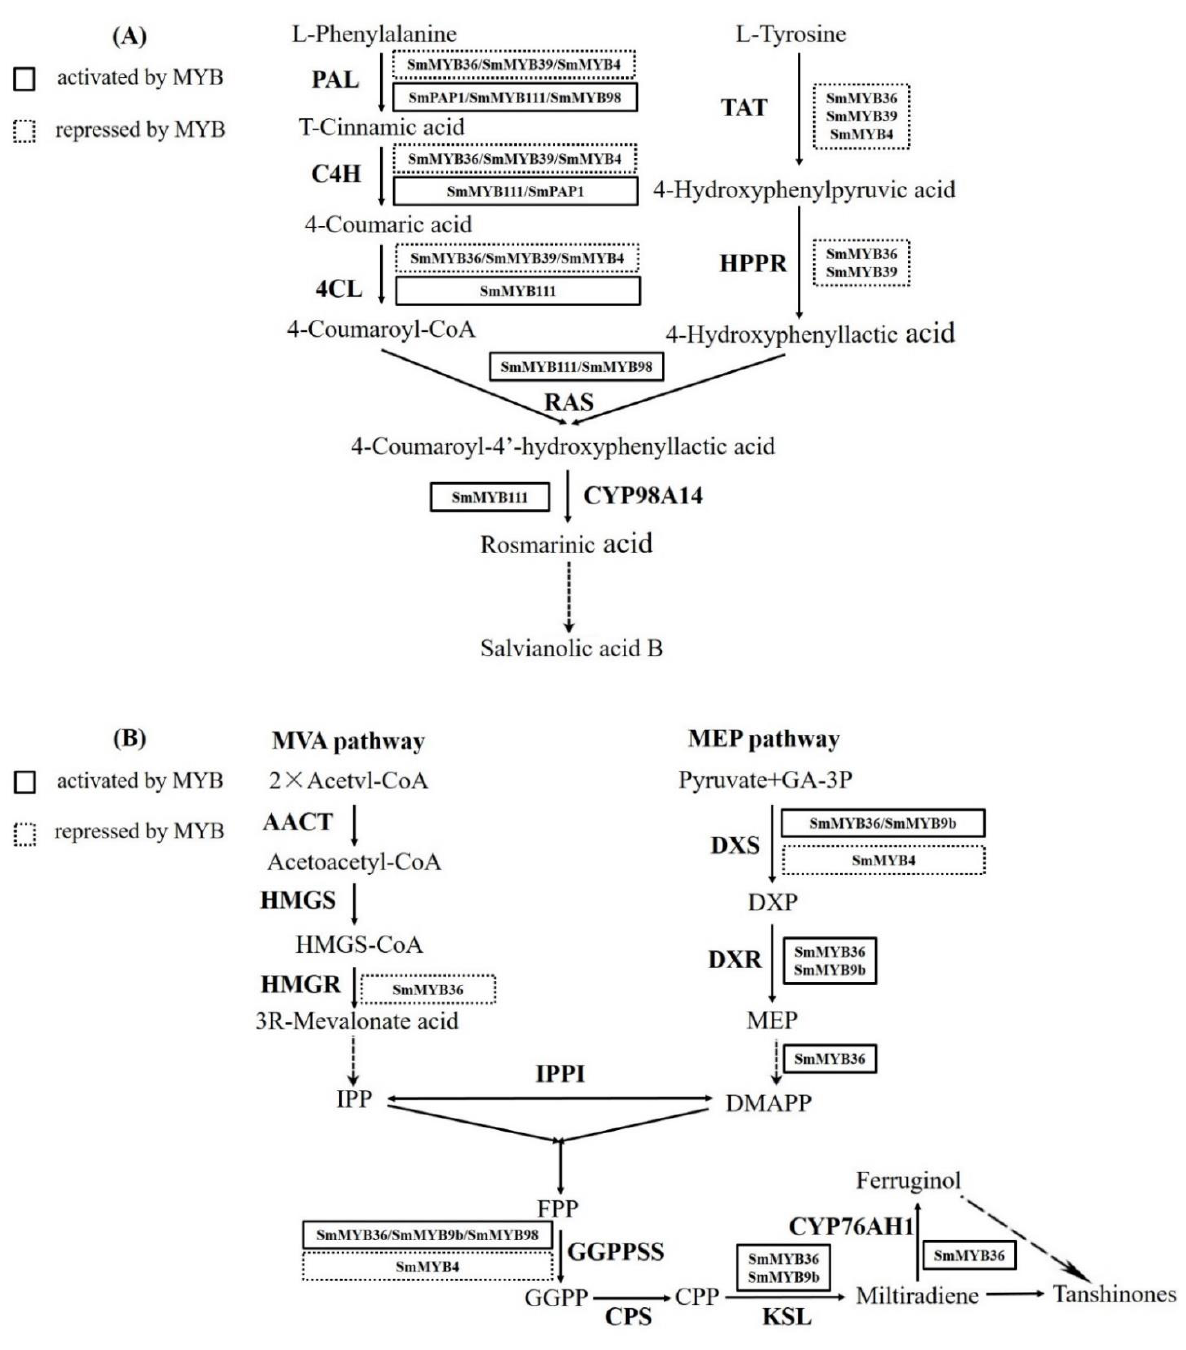
Figure 7. Multiple R2R3-MYBs regulating the salvianolic acid and tanshinone biosynthetic pathways in S. miltiorrhiza . ( A ) indicates multiple R2R3-MYBs regulating salvianolic acid synthesis pathway, and ( B ) indicates multiple R2R3-MYBs regulating tanshinone biosynthetic pathway.